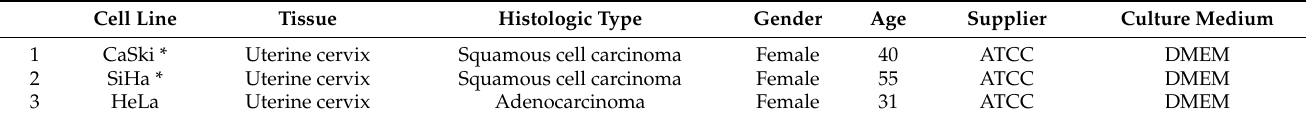
Table 8. Cancer cell lines in the main